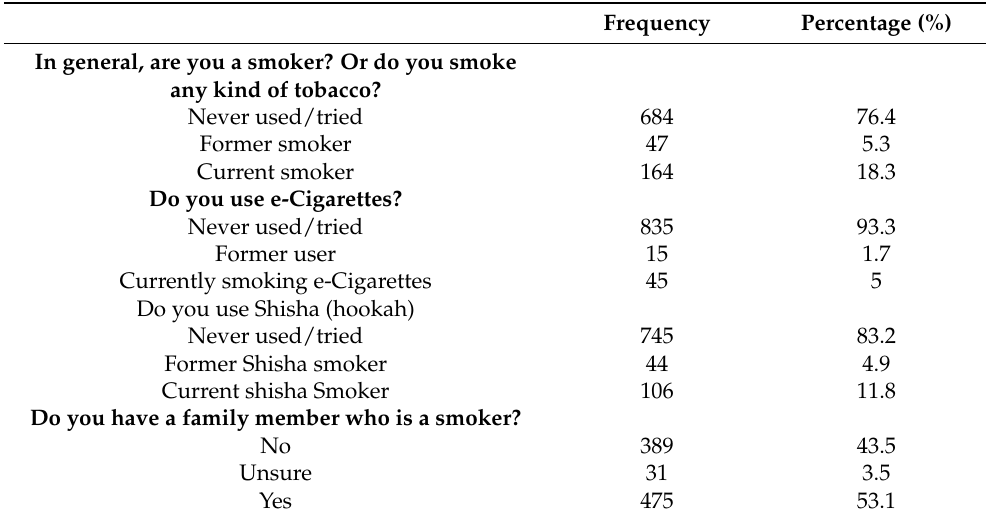
Table 2. Current smoking habits.